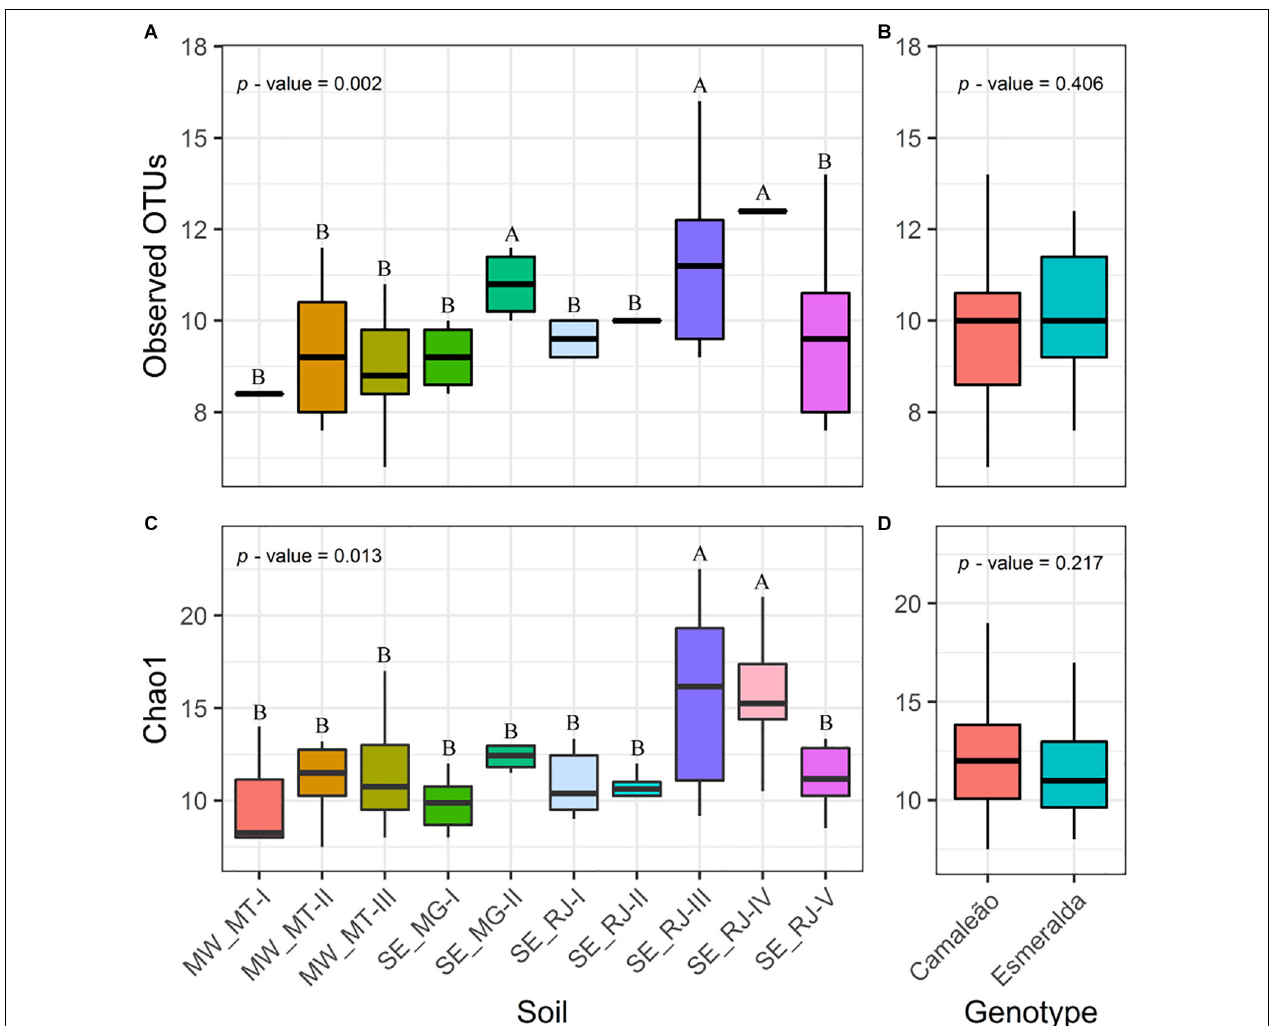
FIGURE 3 | (A,B) Number of observed OTUs and (C,D) estimated richness by Chao1 of bacterial communities from nodules of Camaleão and Esmeralda mung bean genotypes inoculated with 10 different soils. p -values are based on anava. Distinctive letters indicate statistical difference by the Scott–Knott test at 5%